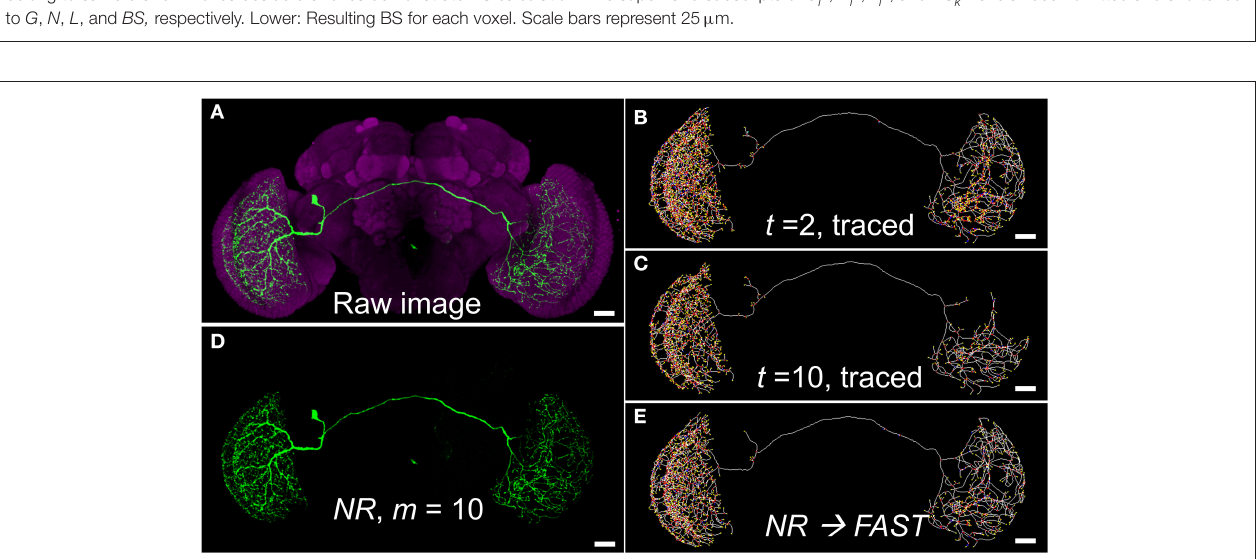
FIGURE 2 | An example of segmentation dilemma solved by NR . (A) The raw image of a visual neuron ( FlyCircuit Neuron ID: Trh-F-000025, 8-bit, intensity 0–255). (B,C) Skeletons traced by FAST with global thresholds t = 2 and 10, respectively. (D) The neuron segmented by NR with HDR thresholding mask at m = 10, fine-tuned from the default value of m = 40, for the best segmentation. (E) Skeleton of (D) traced by FAST . Scale bars represent 25 µ